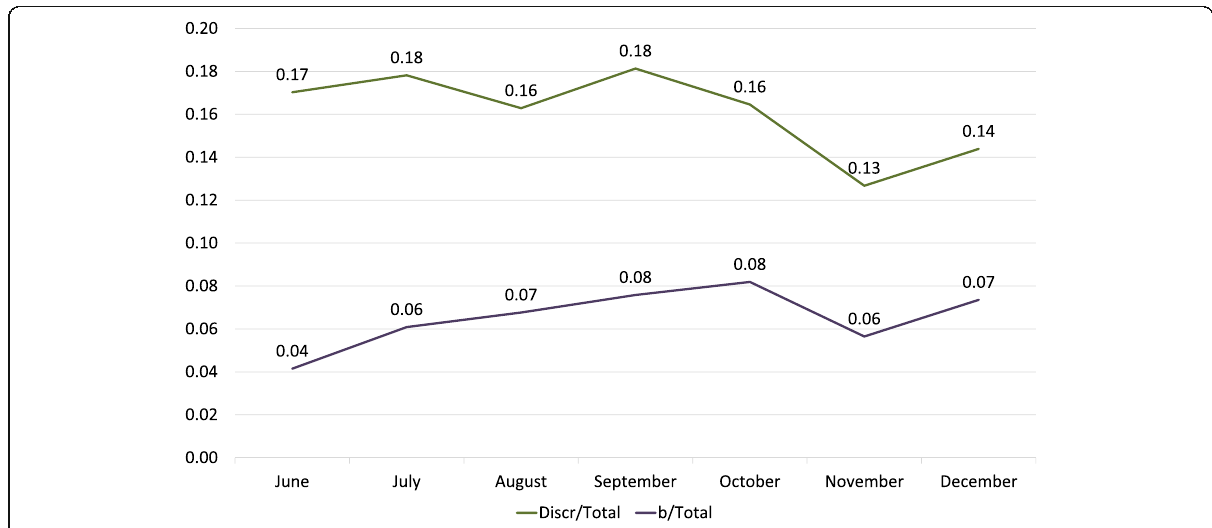
Fig. 4 Evolution of indicators over time in 2nd-year residents evaluation. Discr/Total is the total of discrepancies over the total of preliminary reports (excluding score 0), and b/Total is the total of likely to be clinically significant discrepancies (scores 2b, 3b, 4b) over the total of preliminary reports (also excluding score